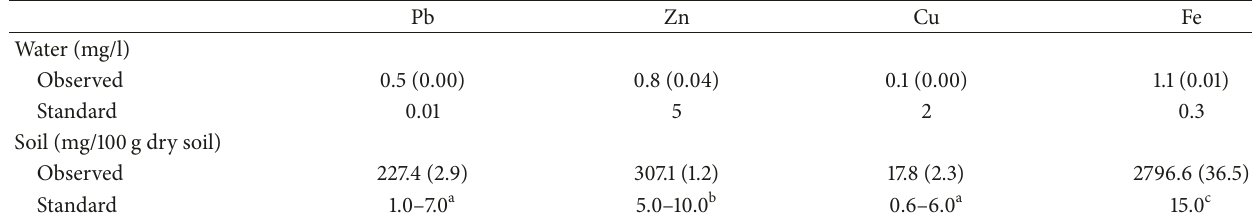
Table 2: Observed mean ( ± standard deviation) of heavy metal levels in water and soil ( 𝑛 = 6). Pb Zn Cu